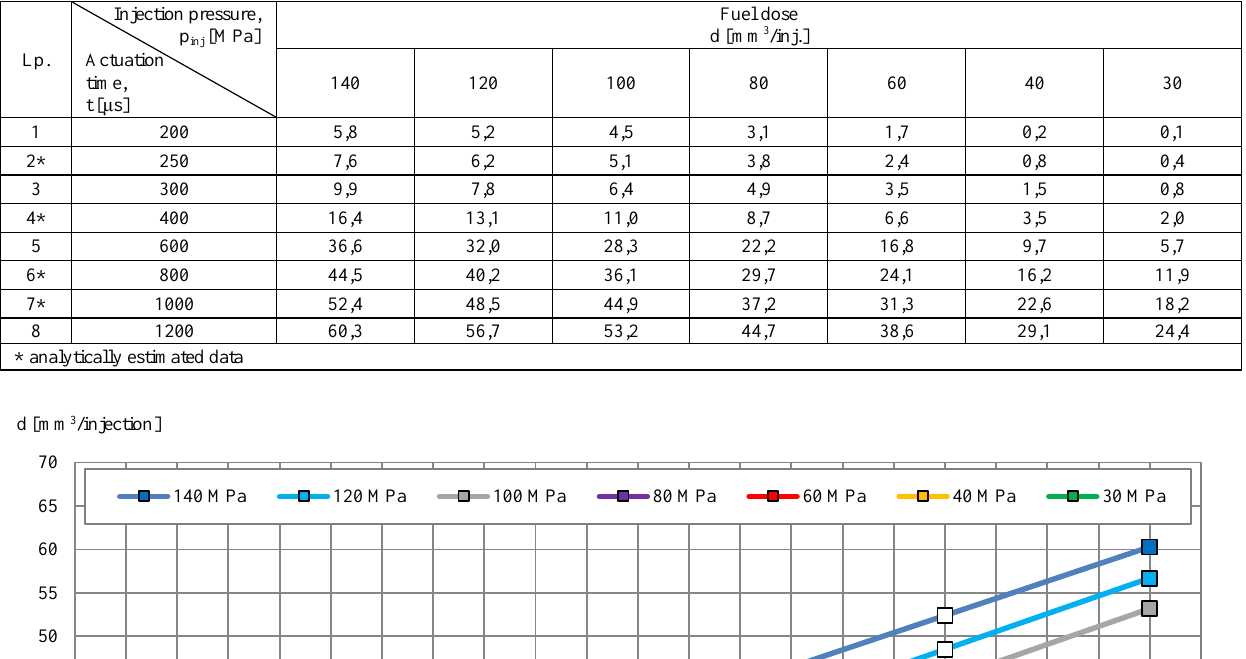
Table 1. Results of test-bench test and calculations for CRI1 Bosch injector